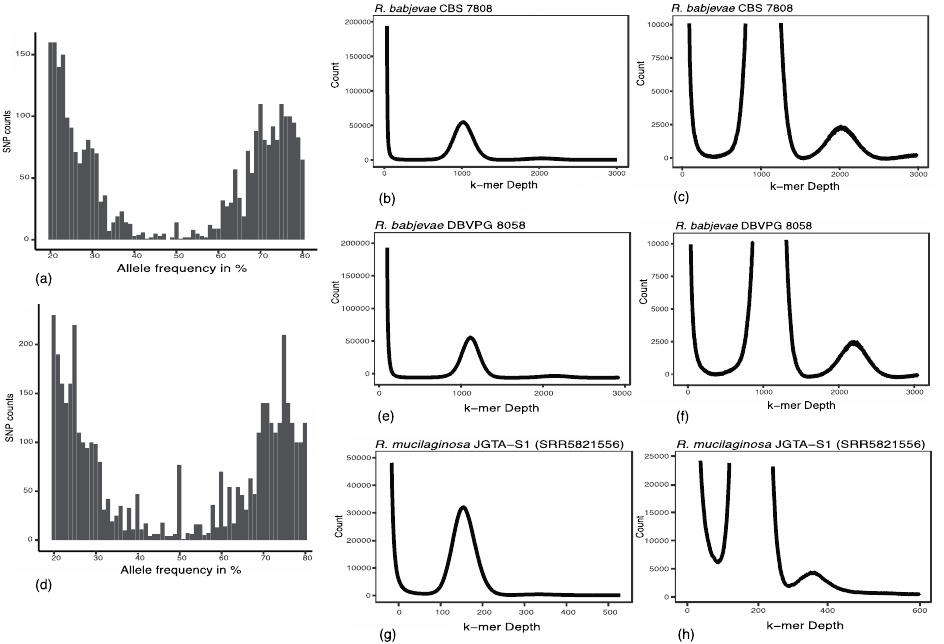
Figure 2. Ploidy estimation of Rhodotorula babjevae and Rhodotorula mucilaginosa . R. babjevae CBS 7808: ( a ) Allele frequency values of single nucleotide polymorphisms (SNP) obtained through nQuire calculations using minimap2, ( b ) Distribution of 17-kmer frequencies using KmerCountExact from the BBmap package, ( c ) Zoomed in peaks of the 17-kmer frequency histogram. R. babjevae DBVPG 8058: ( d ) Allele frequency values of SNP ( e ) Distribution of 17-kmer frequencies, ( f ) Zoomed in peaks of the 17-kmer frequency histogram. R. mucilaginosa JGTA-S1: ( g ) Distribution of 17-kmer frequencies, ( h ) Zoomed in peaks of the 17-kmer frequency histogram. The reproduction of R. mucilaginosa JGTA-S1 ploidy estimation was performed using the Illumina data SRR5821556.